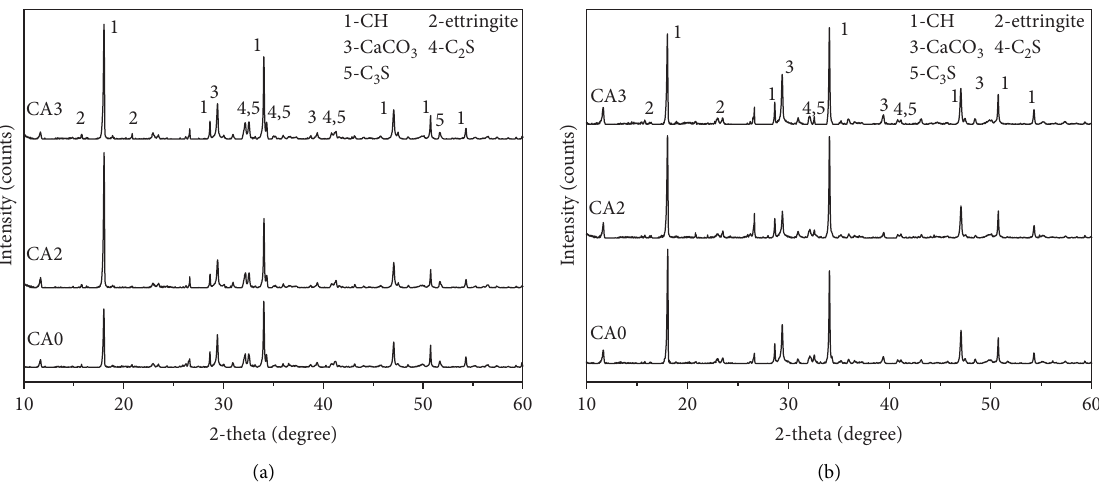
Figure 2: XRD patterns of the different samples after curing for (a) 3 days and (b) 28